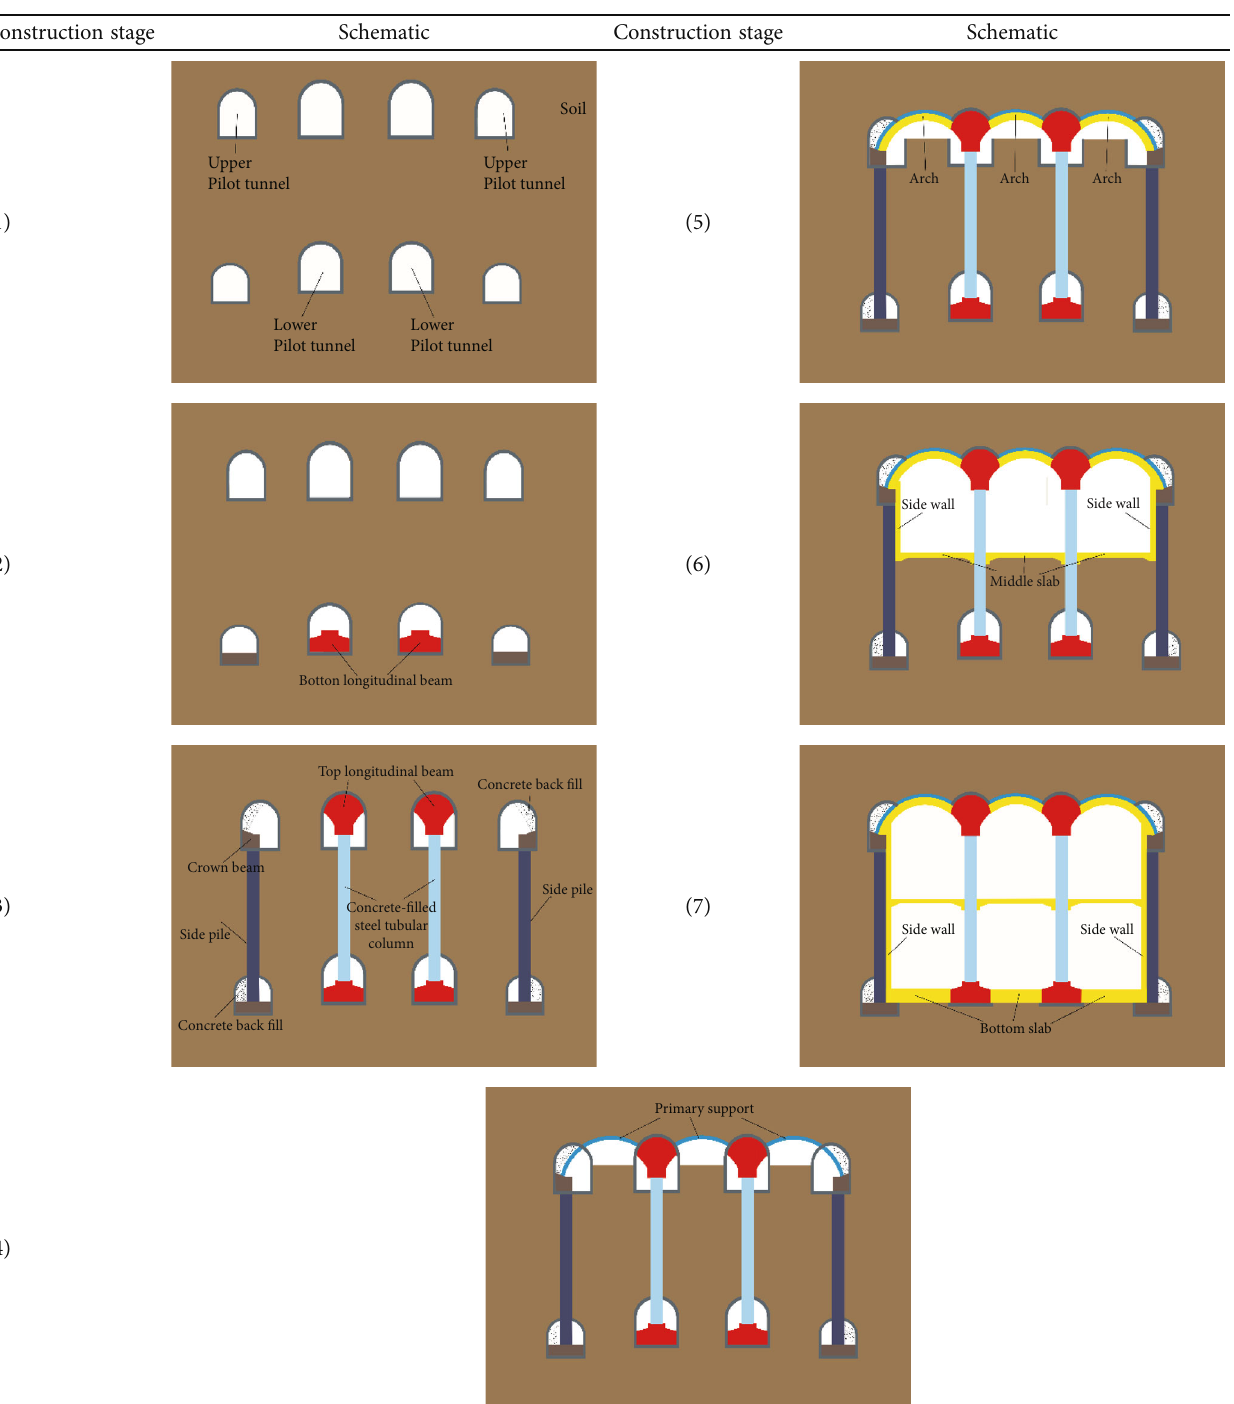
Table 1: Construction